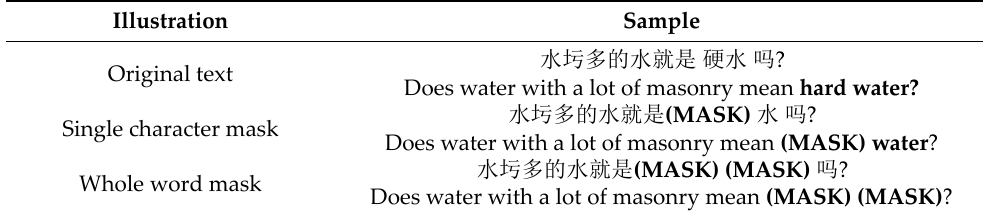
Table 1. Examples of different masks. Illustration